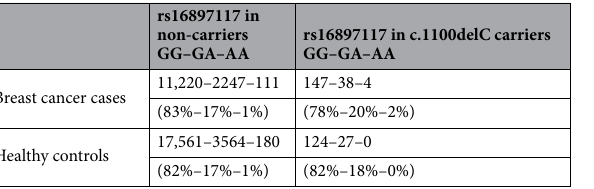
Table 2. BCAC breast cancer cases and healthy controls with available data on CHEK2 :c.1100delC and rs16897117 from the OncoArray project.